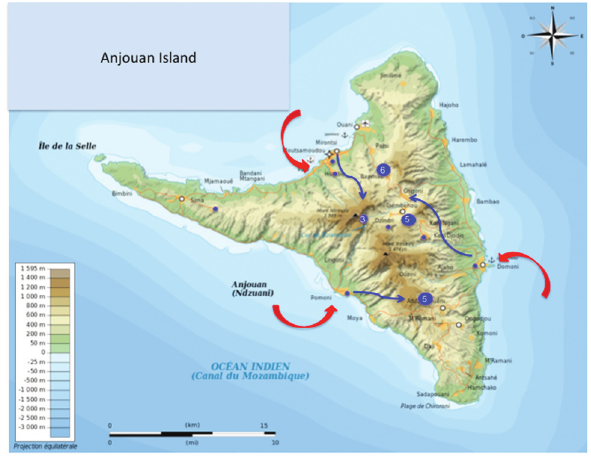
Figure 4 - Localization of the villages where the XP-C families are still living in Anjouan. Anjouan is a small (424 km 2 ) volcanic island. The red arrows indicate the major harbors where the Arabs probably arrived dur- ingthe10 th to13 th centuriestocolonizetheisland.Thebluearrowssuggest thattheeastAfricanBantuescapedtheslaveryprocessbymovingtosmall villages with difficult access inside valleys between the volcanic moun- tains. The blue circles with numbers correspond to the number of XP-C patients found today in these villages. The small blue circles correspond to auniqueXP-Cpatientfoundineachofthethreemajorharborsandbiggest cities of the island (Moutsamoudou, Pomoni,